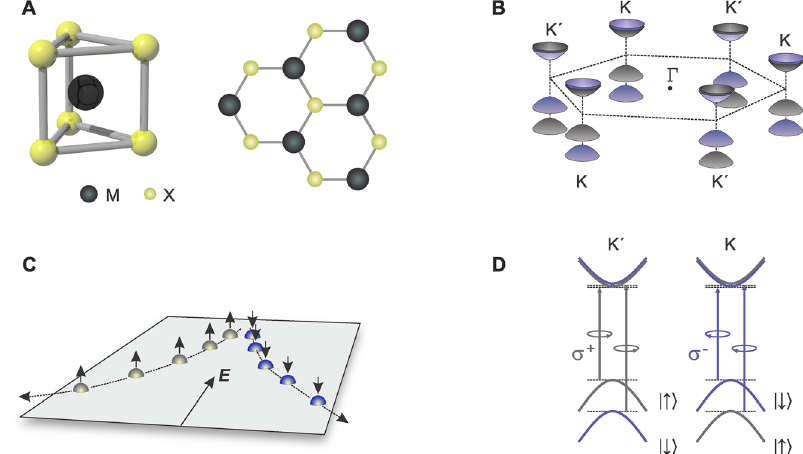
Figure 3: Valley optoelectronics in monolayer TMDs. (A) Hexagonal crystal structure of monolayer TMDs. Black (yellow) denotes the